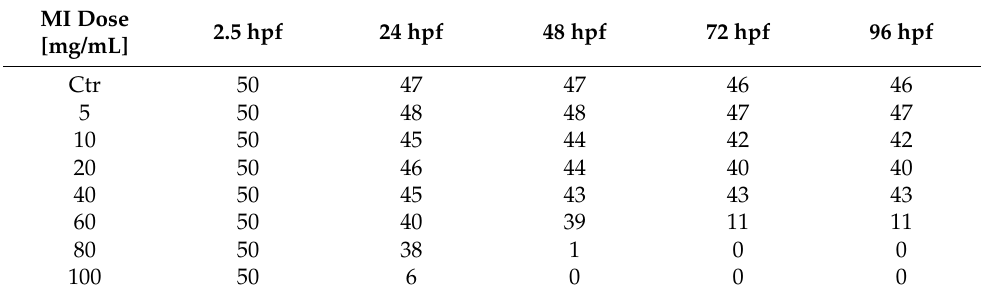
Table 1. Number of zebrafish embryos (2.5, 24, and 48 hpf) and larvae (72 and 96 hpf) survival after MI exposition. Ctr–control group; individuals were treated by elevating concentrations of MI solutions from 5 to 100 mg/mL. Effects of different concentrations of MI were observed after 2.5, 24, 48, 72, and 96 h post-fertilization